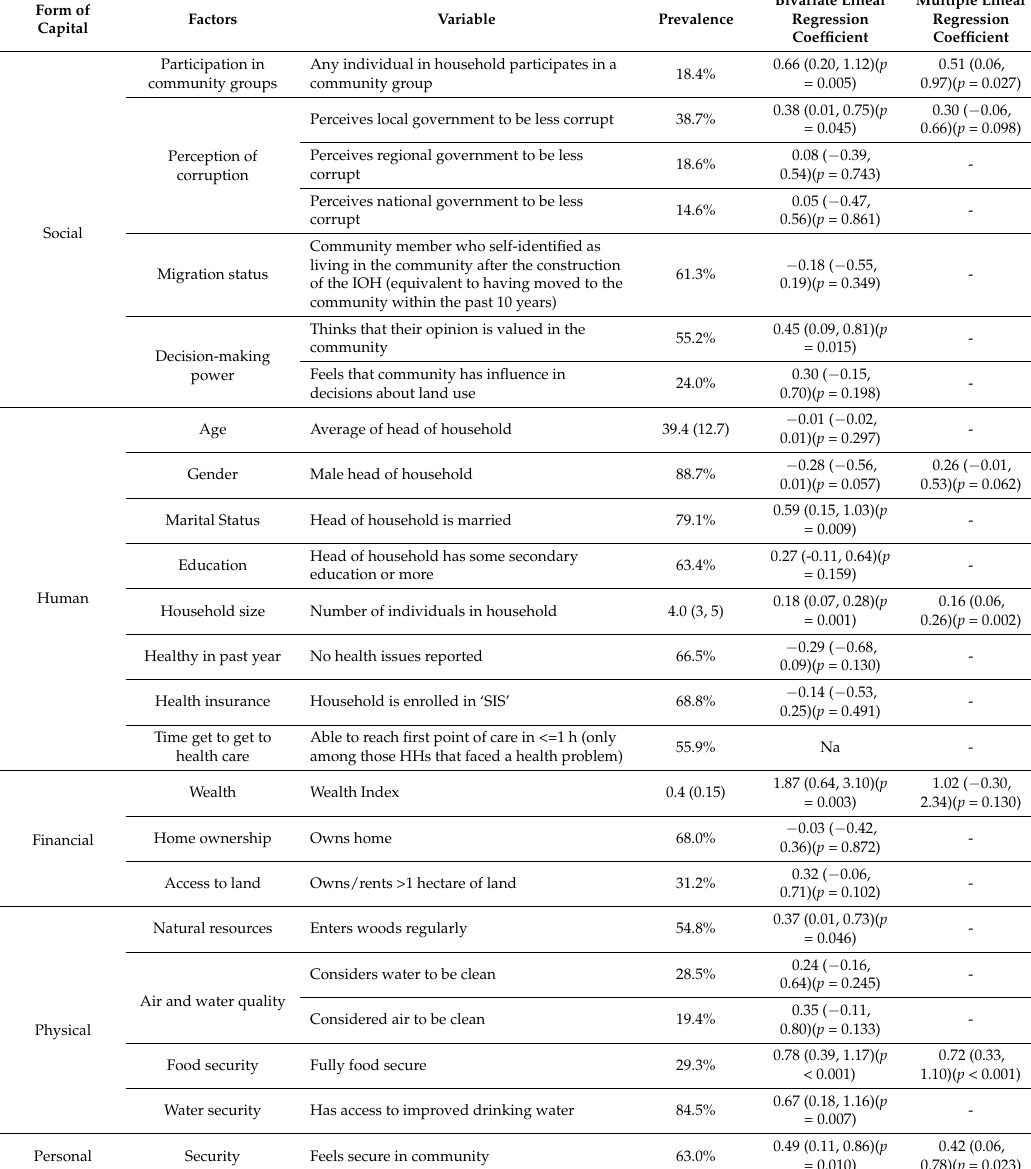
Table 3. Multivariate Regression Results: Specific Factors as per survey (derived from initial FGD &